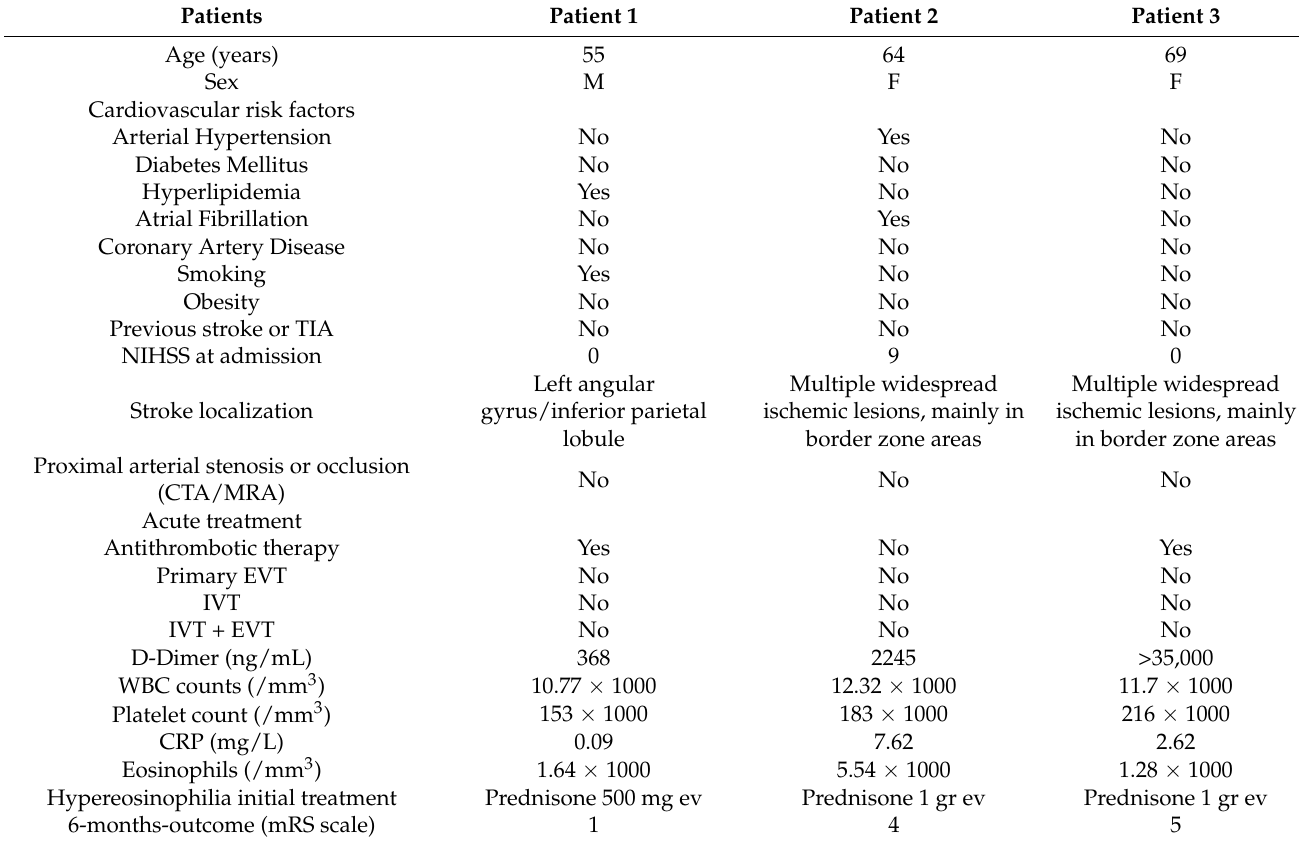
Table 1. Main clinical features of the three